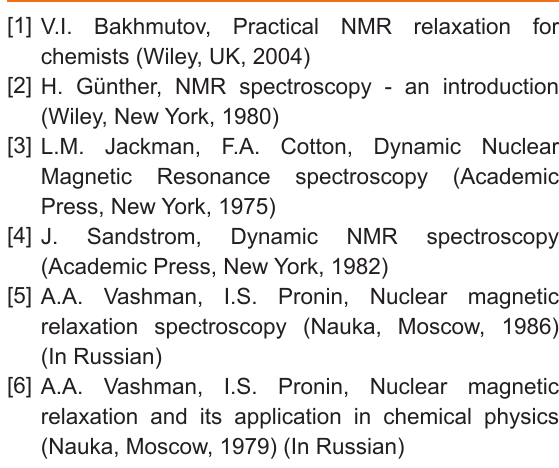
solu ti on at different 6